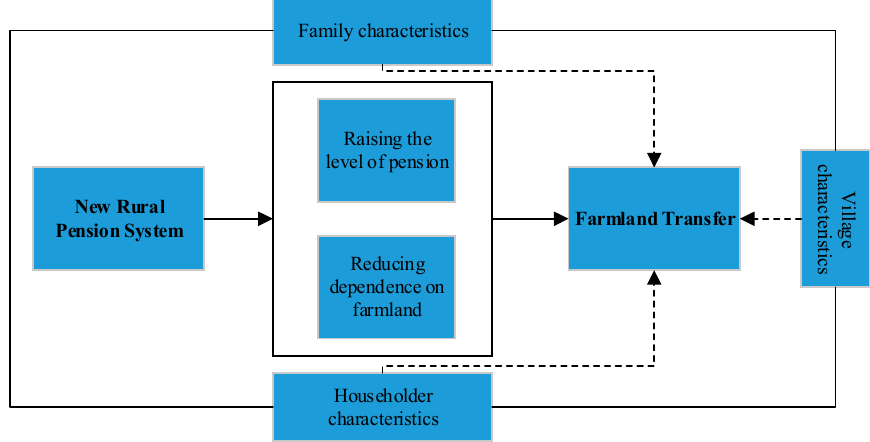
Figure 3. Mechanism analysis of the impact of NRPS on land Figure 3. M e chanism analysis of the impact of NRPS on land transfer.